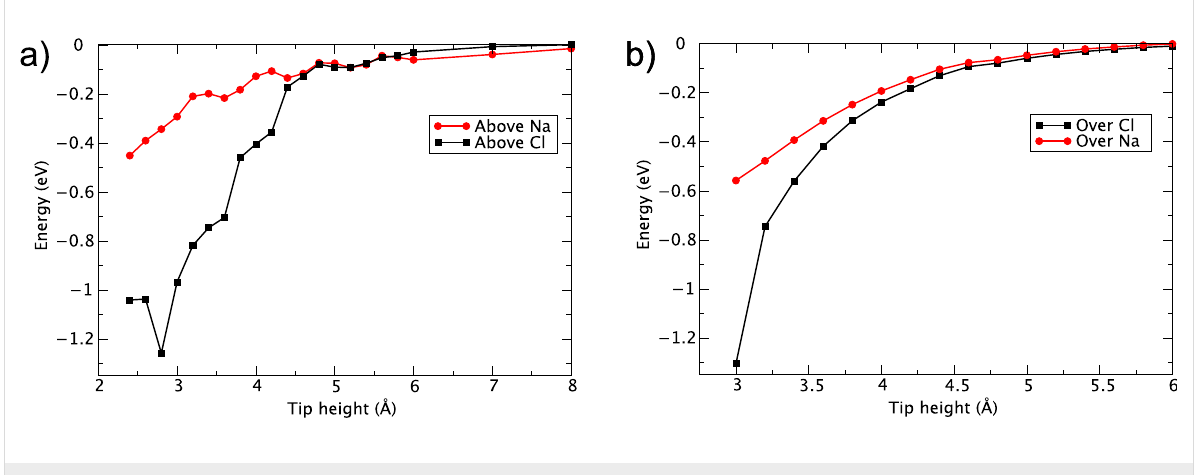
In each of the tip–surface combinations, the calculated force fields would result in the anions being imaged as prominent protrusions in a constant-frequency-shift image of the surfaces. To demonstrate this, and show the extent of typical atomic scale corrugation, we simulated the imaging of the NaCl surface with the Cr cluster tip, using typical imaging parameters based on a traditional silicon cantilever (listed in the Experimental section). The force field used for these calculations was calculated on a lateral square grid with a spacing of 1/8 of the lattice constant between points (i.e., four points between adjacent surface ions), and between tip heights of 3 Å and 7 Å. Figure 4 shows a constant- Δ f image ( Δ f = − 60 Hz) of the NaCl surface, in which the distance of closest approach is 3.6 Å. The rumpling is approximately 0.6 Å with the protrusions corresponding to Cl − ion lattice positions and depressions to Na + ion